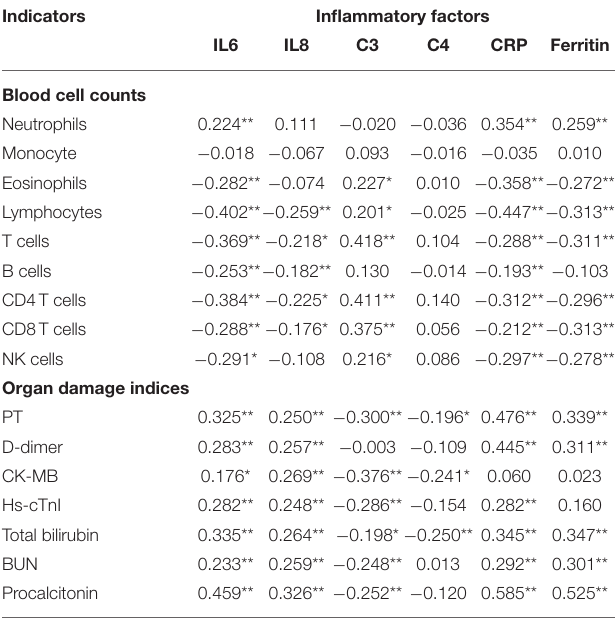
TABLE 5 | Correlation analysis was evaluated between blood cell counts, organ damage indices, and inflammatory factors.